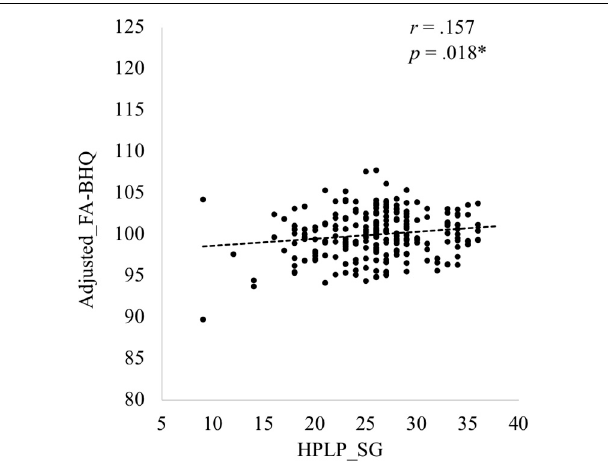
FIGURE 1 | Scatter plot of the adjusted Fractional Anisotropy Brain Healthcare Quotient (FA-BHQ), adjusted for age, sex, and Body Mass Index based on the general linear model, and Health-Promoting Lifestyle Profile (HPLP) Spiritual Growth (SG).